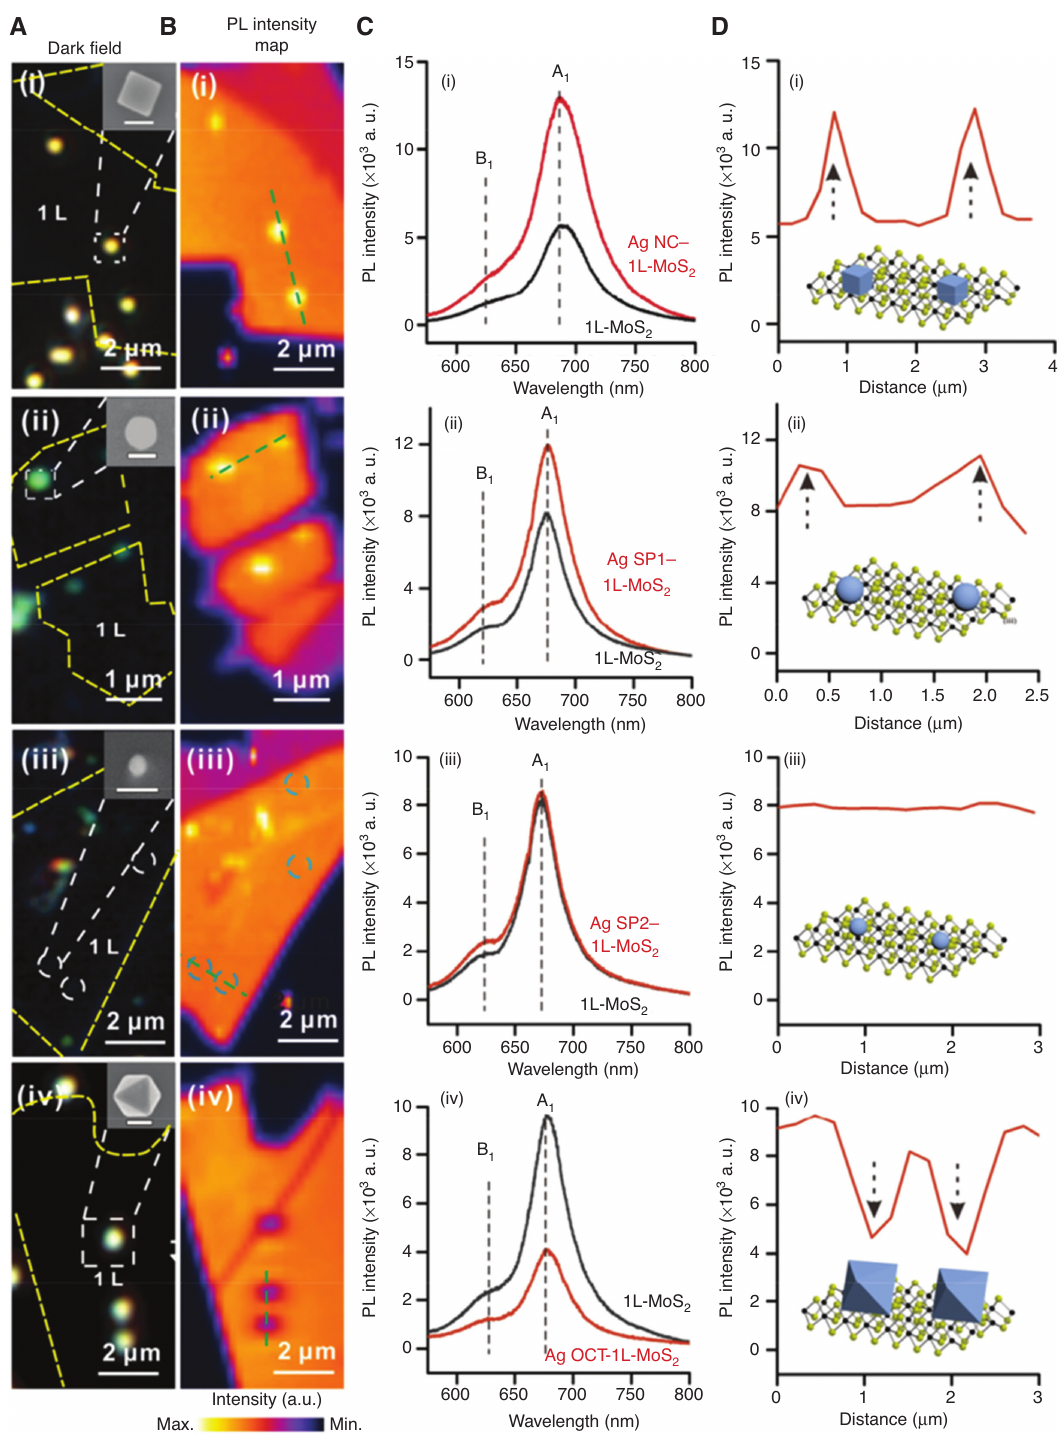
by single shaped Ag nanoantennas. Figure 7: PL tailoring of monolayer MoS 2 (A) Dark-field optical micrograph of monolayer MoS deposited with single shaped Ag NC (i), Ag SP1 (ii), Ag SP2 (iii), and Ag OCT (iv). Insets 2 present the SEM micrographs of single nanoantenna, and scale bars in (i–iii) are 100 nm and (iv) are 200 nm. (B) PL intensity maps of monolayer MoS deposited with single shaped Ag nanoantenna at 680 nm (A1 peak). (C) PL spectra of monolayer MoS 2 Ag nanoantenna. (D) Intensity profile of A1 peak along the dashed line in (B). Reprinted with permission ref.